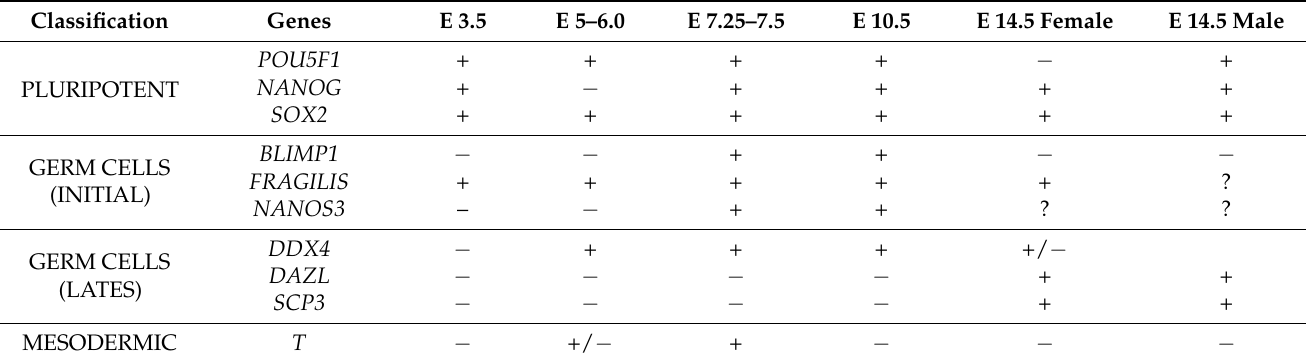
Table 2. A summary of relevant genes for the specification of mouse